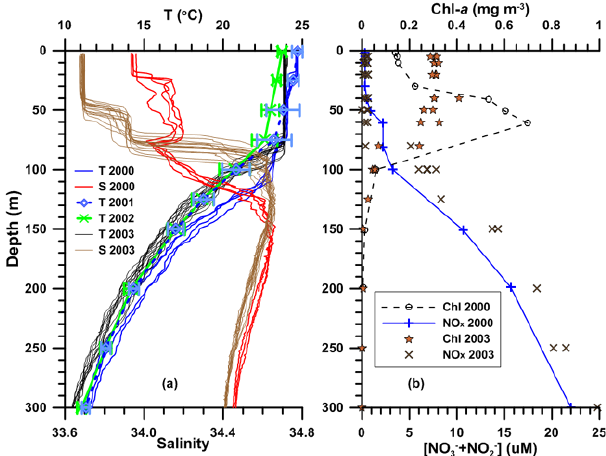
Fig. 13. Observed upper water column conditions in Januaries of different years: (a) Temperature and salinity, and (b) nitrate plus nitrite (NO x )